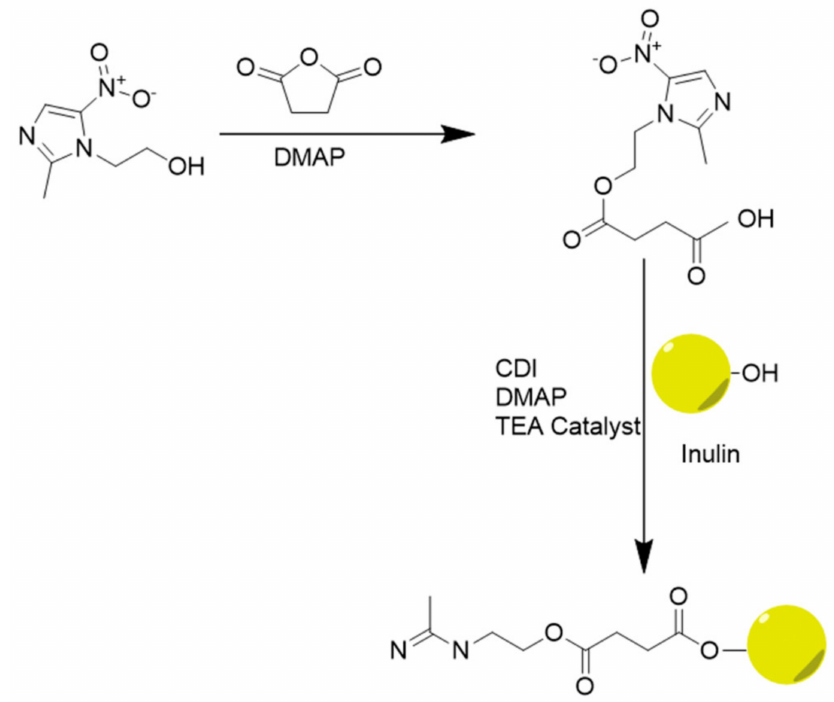
Scheme 1. Esterification of metronidazole to form a